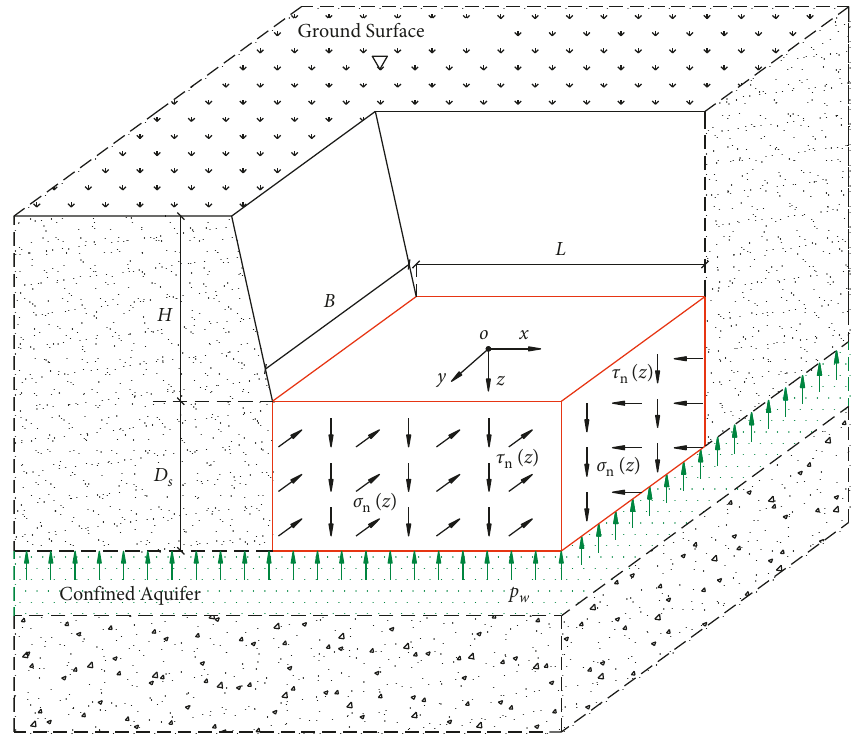
Figure 2: Inrush failure mechanism for a rectangular foundation pit.